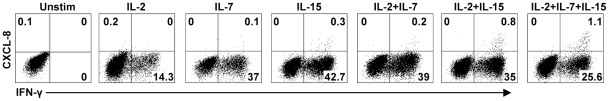
Induction of CXCL-8 in CMV-specific CD8 T cells cultured for 10 d in the cytokine indicated above respective plots.Following expansion, CMV-specific cells were stimulated with 1 µg/ml peptide and stained for CXCL-8 and IFN-γ.